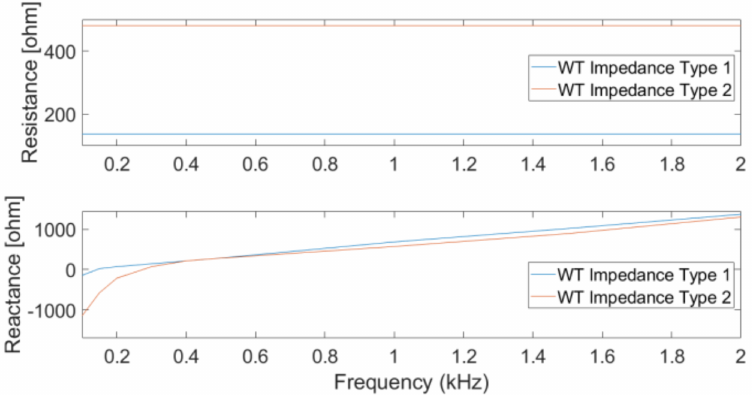
Figure 2. Wind turbine impedance as a function of frequency, as used in this paper. For the calculation of the transfer function, the primary emission is modelled as an ideal voltage or current source. This does not, however, imply any assumption on which model is more representative. When calculating, for example, the transfer admittance, the primary emission for all turbines except the sending one is considered equal to